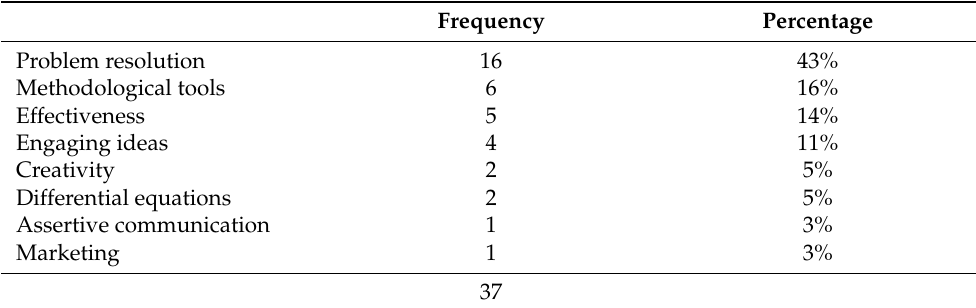
Table 3. MMC learnings.